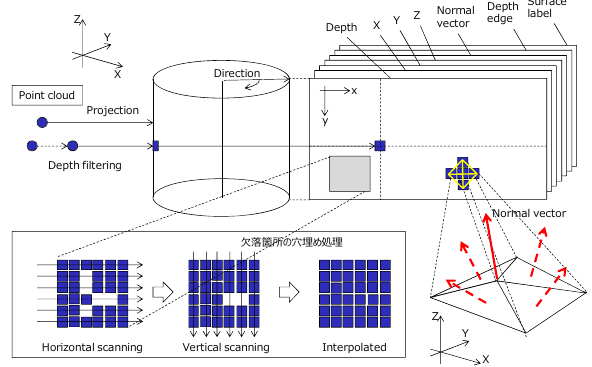
Figure 2. Point-based rendering